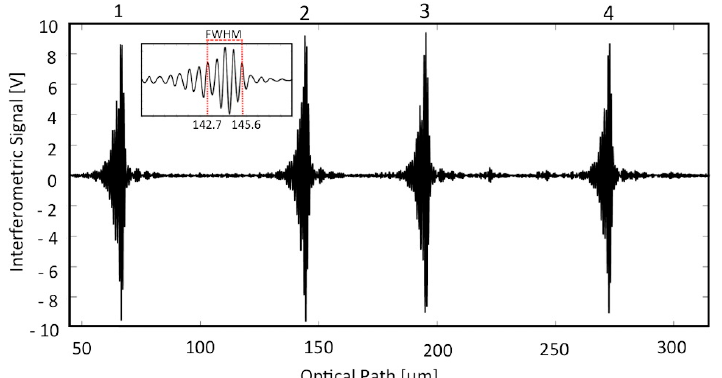
Figure 3. Interferometric signal as a function of the optical path obtained on 50 μ m capillary in presence of air. 1, 2, 3, 4: interface positions, defined in Figure 1b. Inset: zoom of the second group of fringes. FWHM: Full width at half maximum.